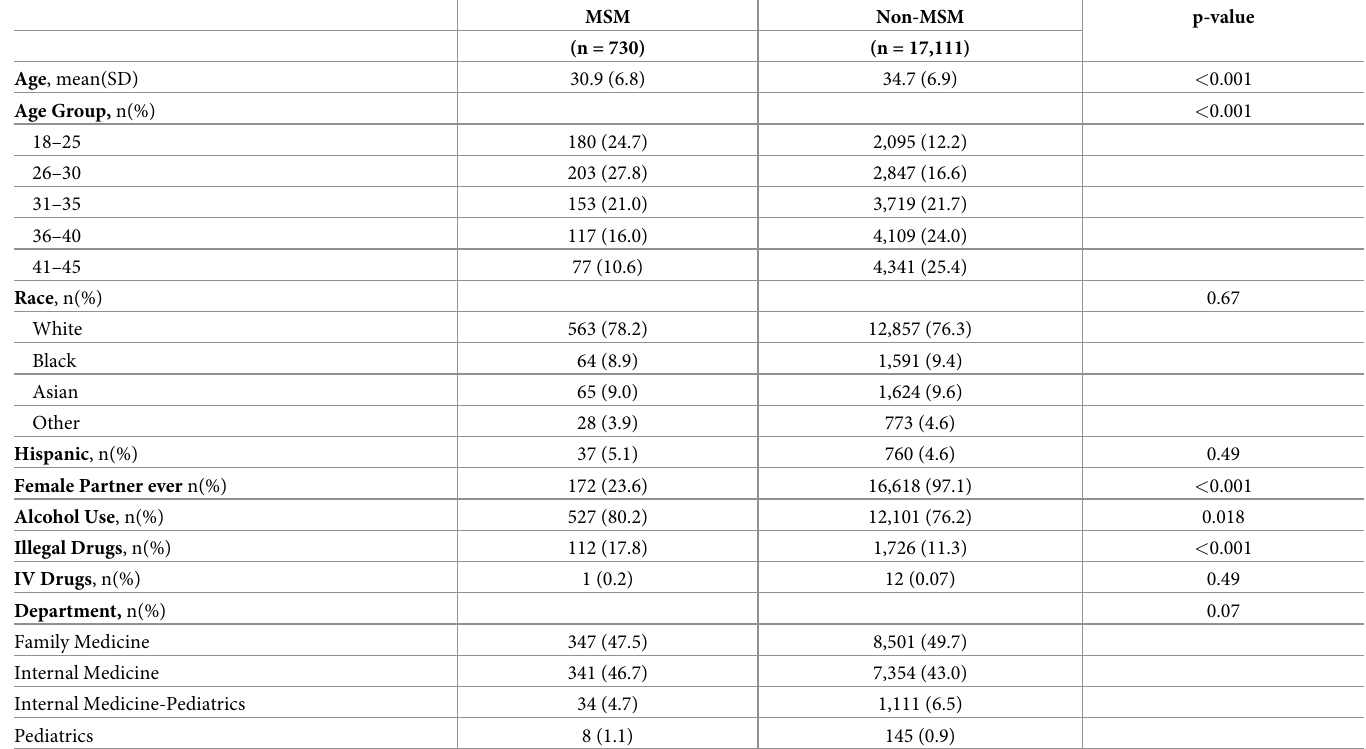
Table 1. Characteristics of MSM and non-MSM.